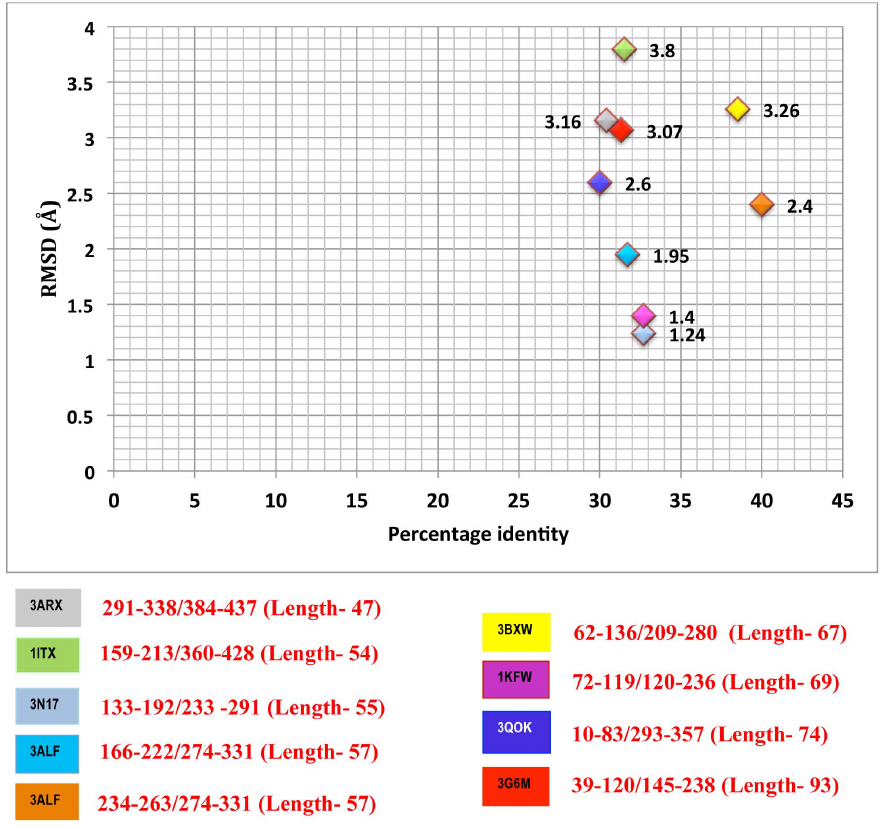
Figure 1. Relationship between RMSD values and percentage identity of TIM fold intra-repeats.